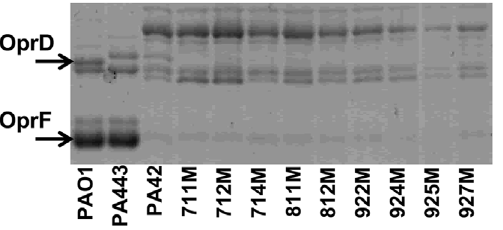
Figure 3. Outer membrane analysis of P.aeruginosa PA42 and nine isogenic mutants. Outer membrane profiles were analyzed for the presence of the porin, OprD. PAO1 and a fully susceptible cystic fibrosis isolate, PA443, were included as positive controls. The locations of OprD and OprF proteins are indicated.